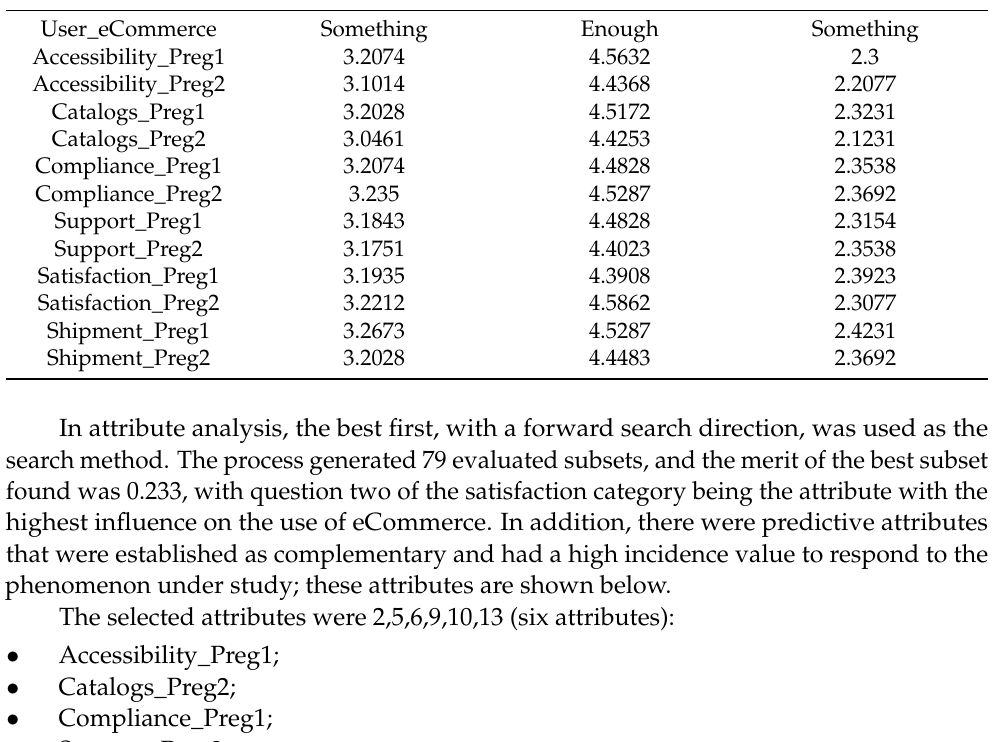
Table 19. Training of a data mining algorithm with two clusters to determine the use of eCommerce. Full Data Cluster#1 2 Attribute (217) 109 108 User_eCommerce Something Enough